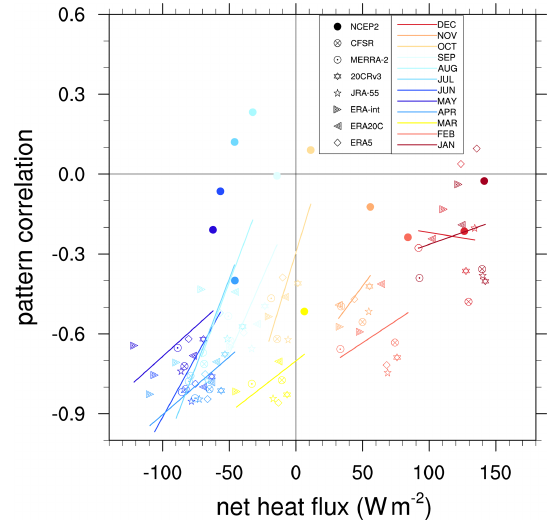
Figure 4. Net heat flux averaged over sea ice zone ( x axis: Wm − 2 , where positive indicates net flux from atmosphere to ocean), against the pattern correlation between reanalysis SIC and SAT (i.e. values plotted in Fig. 3b). Data points are coloured by month with different markers for each reanalysis. Coloured lines show the best-fit line for each month estimated by ordinary least squares